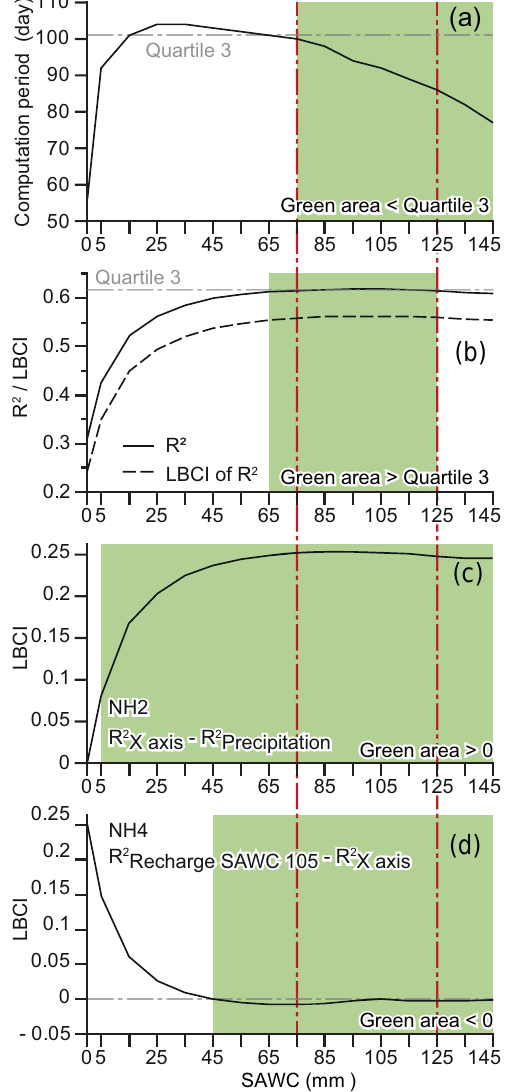
Figure 7. Results of the sensitivity analysis relative to SAWC for (a) the computation period, (b) the R 2 and the LBCI of R 2 , (c) the LBCI of NH2 and (d) the LBCI of